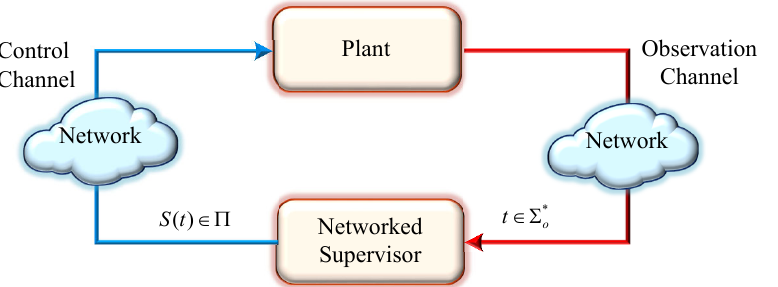
Figure 1. Supervisory control of networked